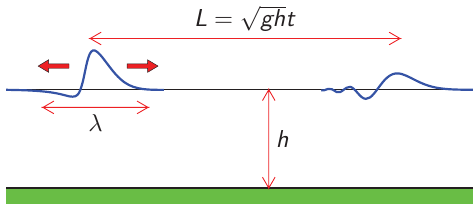
Fig. 1. Definition sketch of the evolution of an initial elevation from an earthquake.